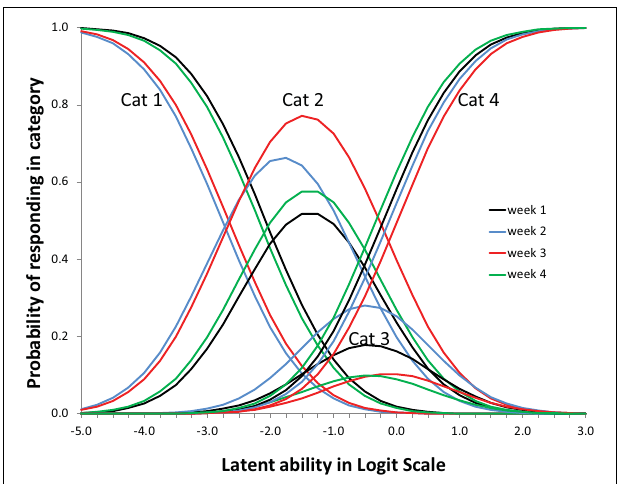
FIGURE 9 | Item profiles for four topic/question sets, while allowing for some measurement differences between weeks. On the x-axis is the latent ability/advancedness scale, as explained